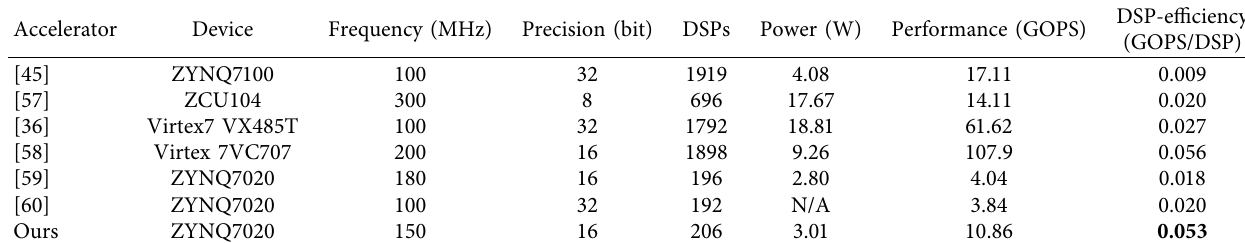
Table 6: Comparison with previous